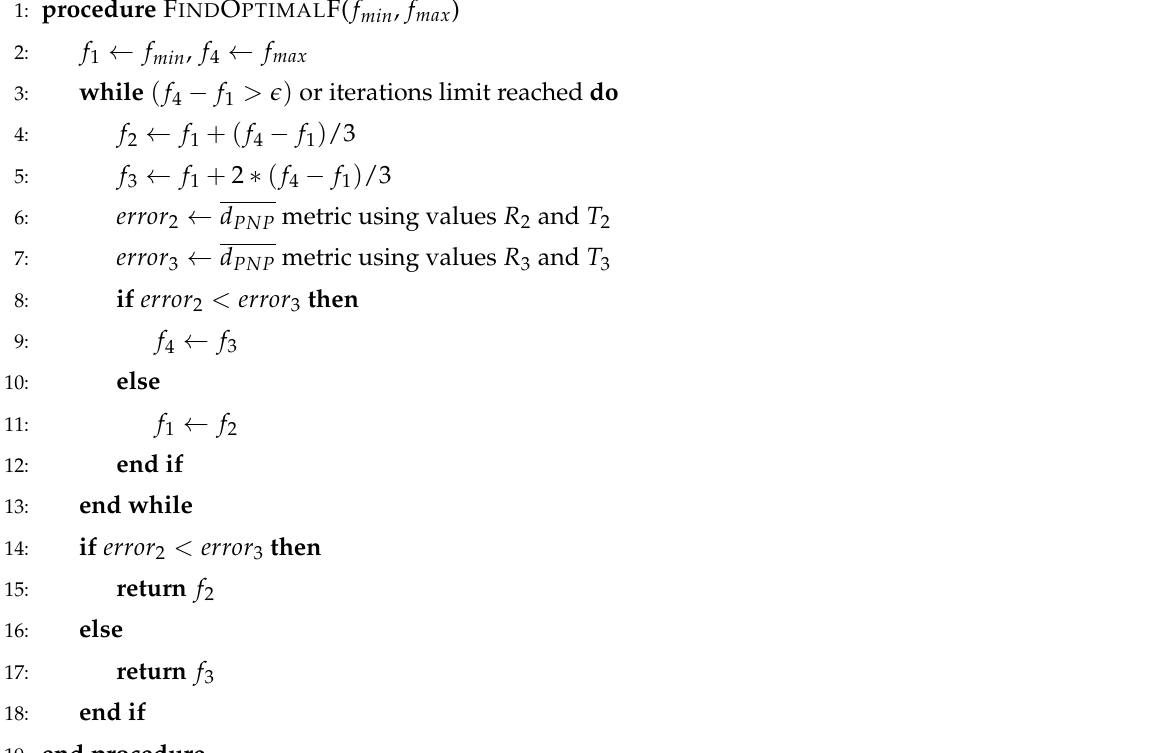
Algorithm 1 Ternary-search focal length scale factor